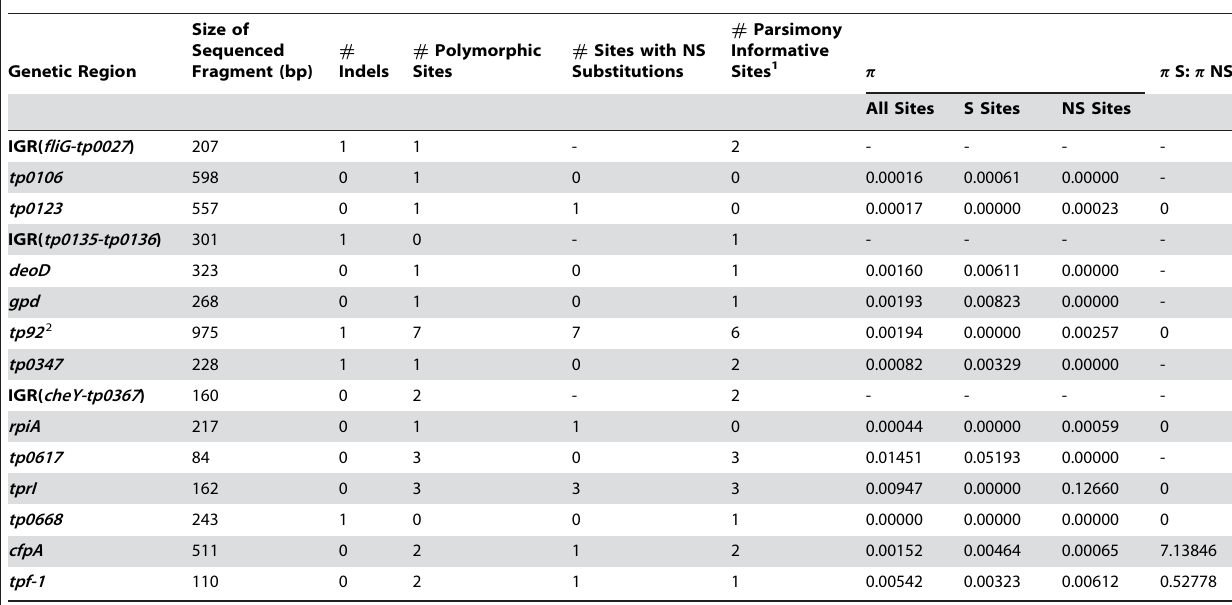
Table 3. Summary of polymorphism found between T. pallidum strains.